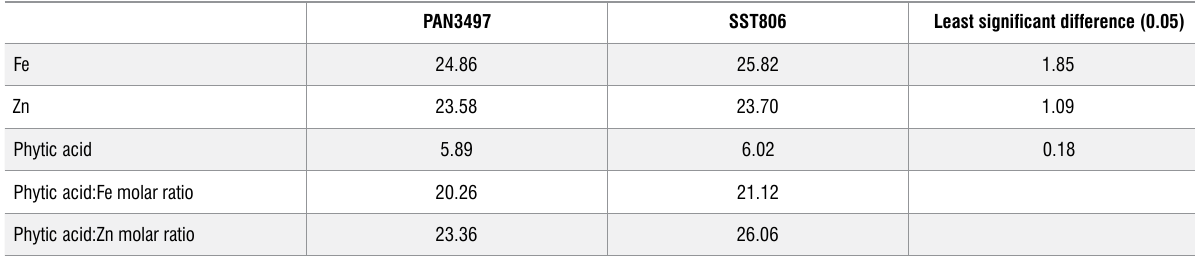
Average values of four treatments for the measured characteris tics over two years separated by two cultivars PAN3497